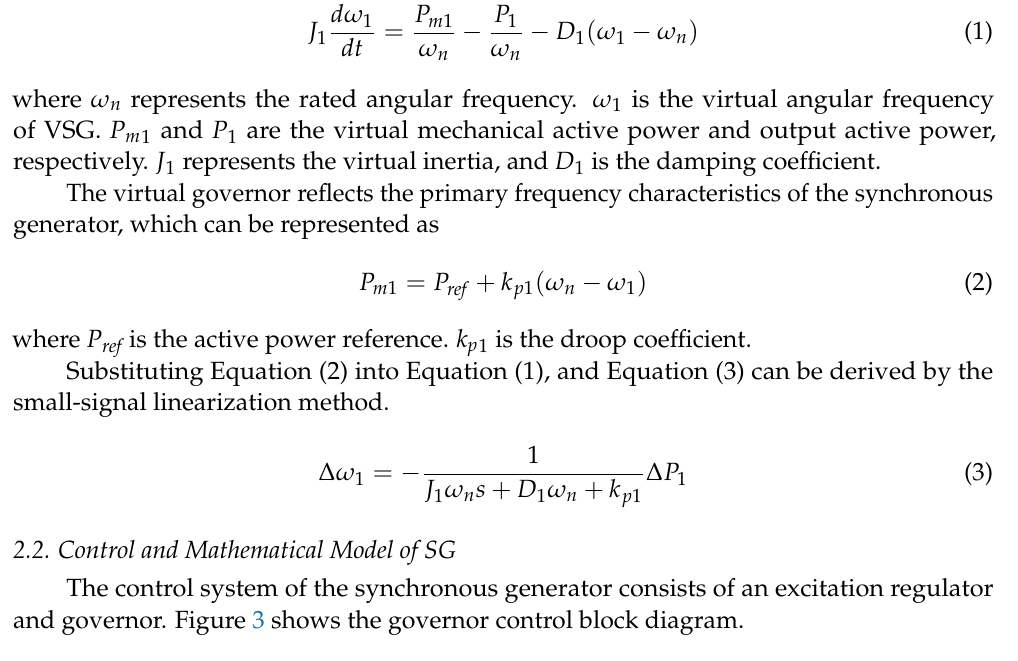
The control system of the synchronous generator consists of an excitation regulator and governor. Figure 3 shows the governor control block diagram.